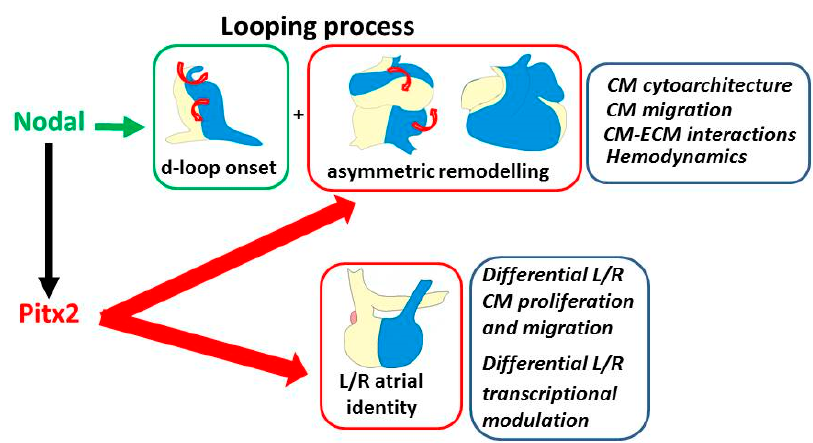
Figure 2. The recognized role of Pitx2 and Nodal in modulation of the two components of cardiac laterality. Top boxes: looping and asymmetric remodeling; the illustrations show the developmental repositioning of the left/right portions of the linear heart (blue/yellow color) with looping progression and, aside, the underlying driving processes. They are initially driven by Nodal in early cardiomyocytes, then reinforced by Pitx2 during development. Bottom box: left–right (L/R) atrial identity; the underlying characteristics, which are under the control of Pitx2, are indicated aside. CM: cardiomyocyte; ECM: extracellular matrix